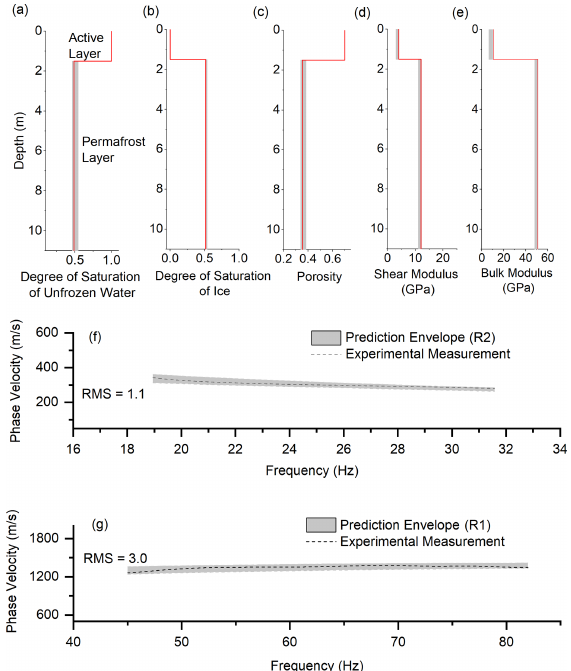
Figure B1. Surface wave inversion results for section 2: 120 to 240m. (a) Degree of saturation of unfrozen water, (b) degree of saturation of ice, (c) porosity distribution, (d) shear modulus of solid skeletal frame, (e) bulk modulus of solid skeletal frame, (f) experimental and numerical dispersion curves for the R2 wave, and (g) experimental and numerical dispersion curves for the R1 wave.